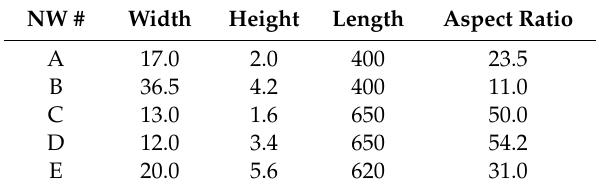
Table 1. The dimensions of the five Fe-silicide NWs (A to E) shown in Figure 3. Units: nm. NW # Width Height